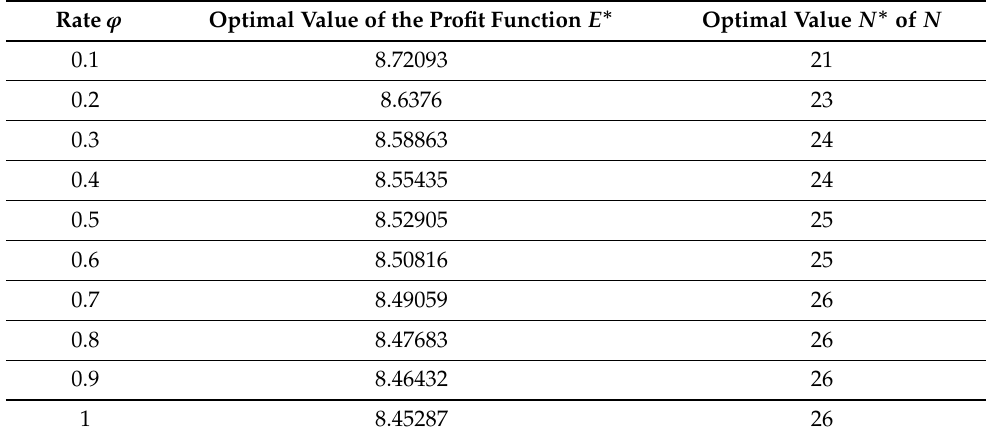
Table 1. Optimal values of the number of servers and the profit function for various values of ϕ . Rate ϕ Optimal Value of the Profit Function E